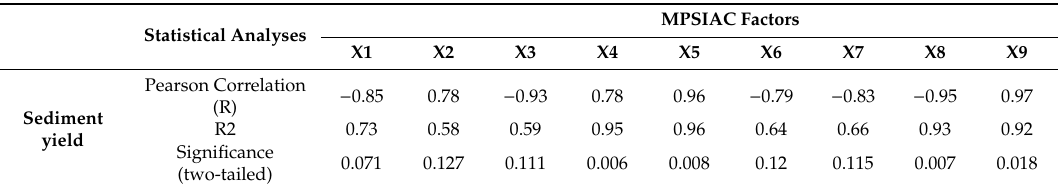
Table 9. Correlation between sediment yield and modified Pacific Southwest Inter-Agency Committee (MPSIAC) factors in the study area.